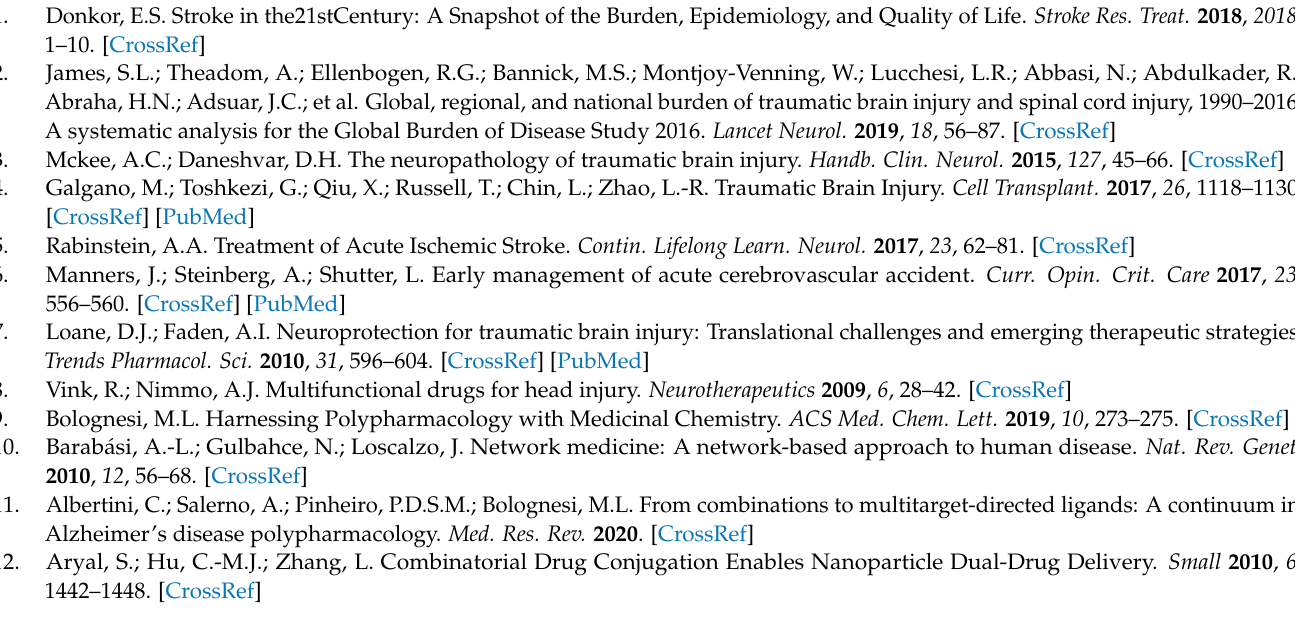
Chromatogram of blank PBS sample. Figure S3: (A) TGA analysis of PLLA (black), Ibu-loaded PLLA (blu), T3-loaded PLLA (red), Ibu (green), and T3 (pink). (B) DSC first heating scans of PLLA (black), Ibu-loaded PLLA (blue) and T3-loaded PLLA (red). (C) DSC first heating scans of Ibu-loaded PLLA before (black) and after (red) sterilization. (D) DSC first heating scans of T3-loaded PLLA before (black) and after (red)